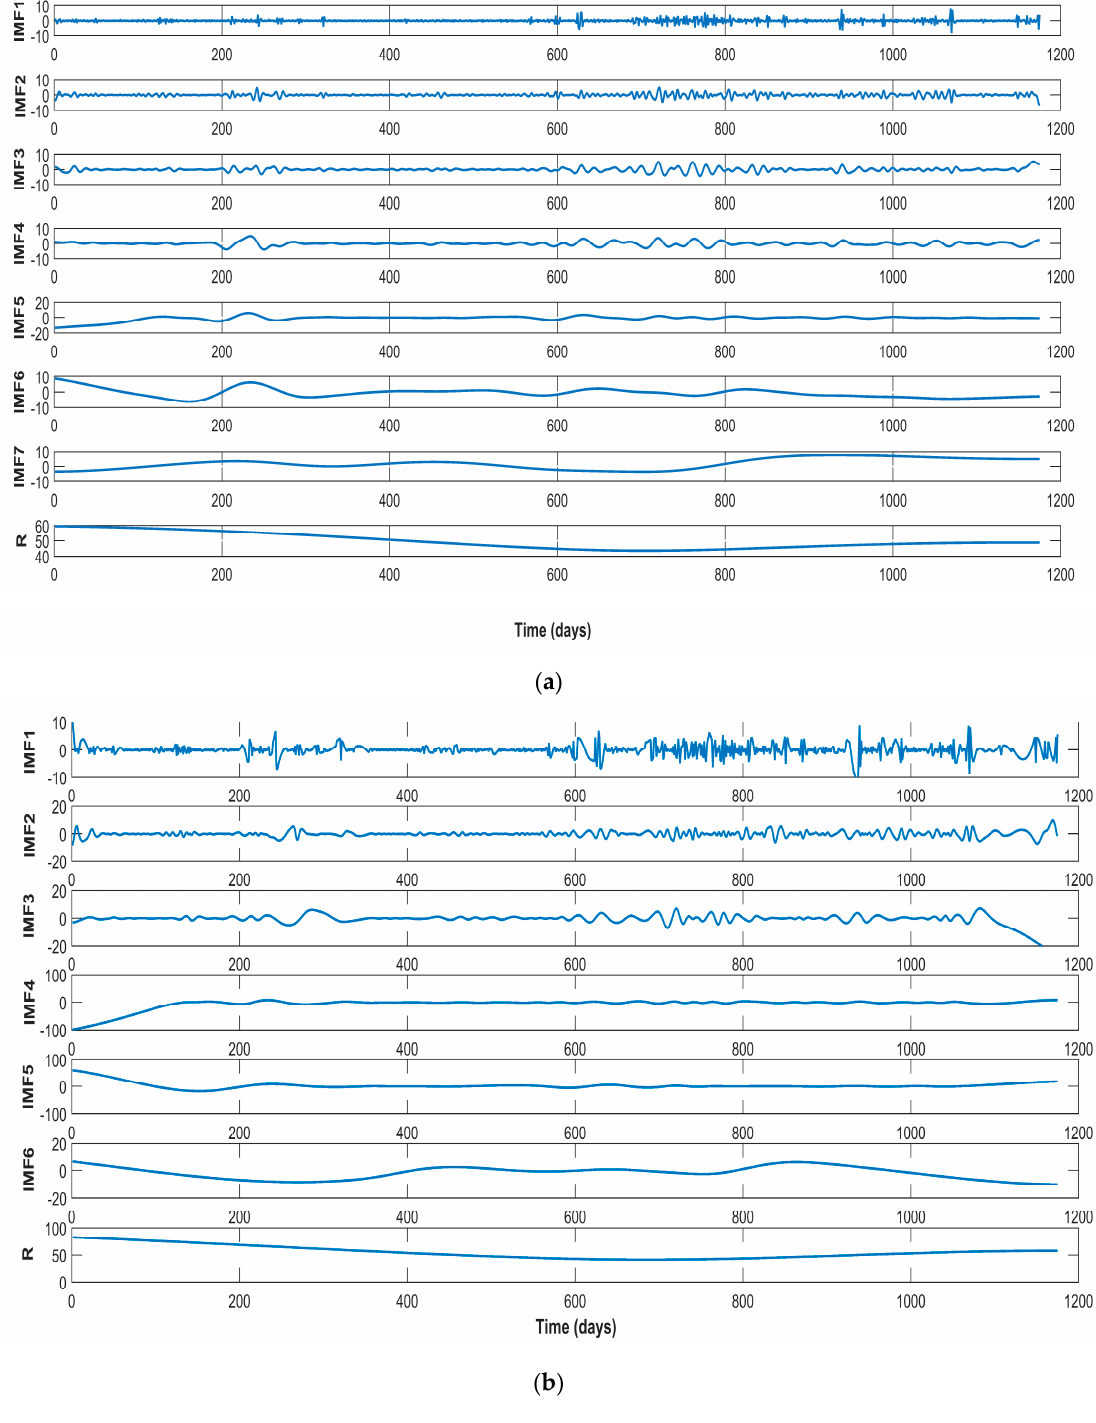
Figure 5. ( a ) The fast ensemble empirical mode decomposition (FEEMD) outcome of the Beijing carbon price series; ( b ) The outcome by the empirical mode decomposition (EMD) method.